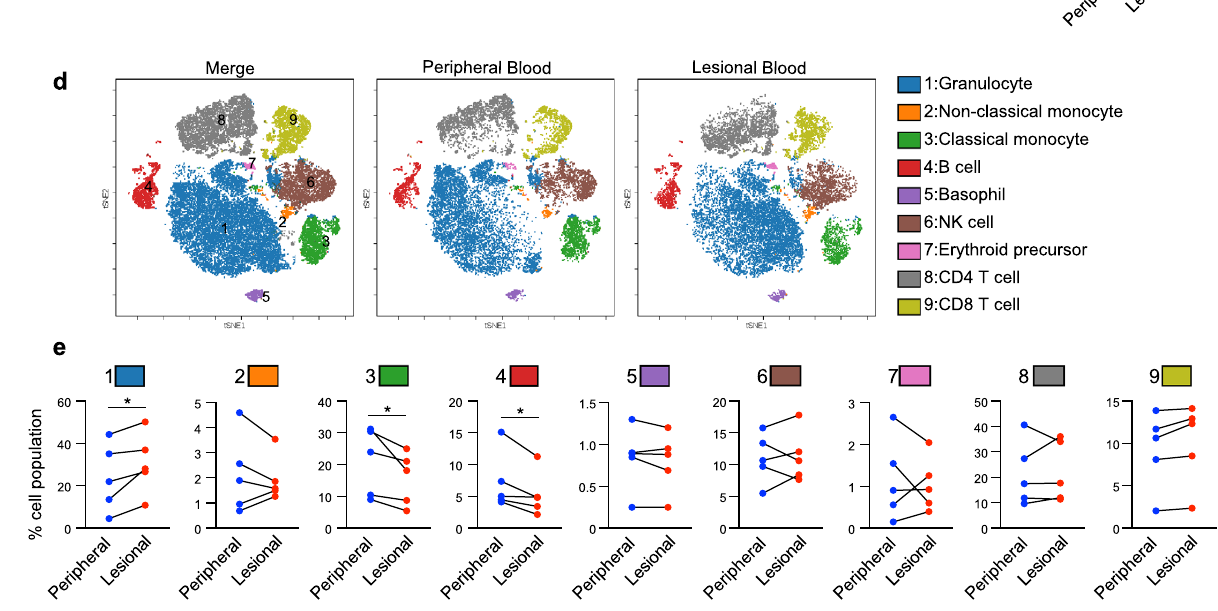
Figure 1. Cell populations differ between peripheral and lesional blood in patients with mycosis fungoides (MF). ( a ) Flow cytometry analysis of CD4 + and CD8 + T cells from 2, 5, and 10 μL peripheral blood for the detection of T cells in small amounts of blood. The number in the upper right corner represents the number of CD4 + and CD8 + T cells. Mean (+ standard deviation) numbers of CD4 + and CD8 + cells (n = 3) are shown in the bar graph (right). ( b ) Lesional blood was collected during a skin biopsy. Peripheral and lesional blood was obtained from the patient’s arm and erythematous lesion, respectively, on the same day. The collected blood cells and serum were used for the subsequent experiments. ( c ) Flow cytometry of CD4 + and CD8 + T cells obtained from 5 μL of peripheral and lesional blood. Numbers of CD4 + and CD8 + T cells in 5 μL of peripheral and lesional blood are shown (right, n = 4). ( d ) Representative mass cytometry analysis of peripheral and lesional blood from a patient with MF through viSNE analysis using Cytobank. The color of each dot represents the immune cell subset. ( e ) The proportion of each cell population in peripheral and lesional blood obtained from patients with MF (n = 5) quantified by mass cytometry. A paired t -test was used for the statistical analysis. * P <